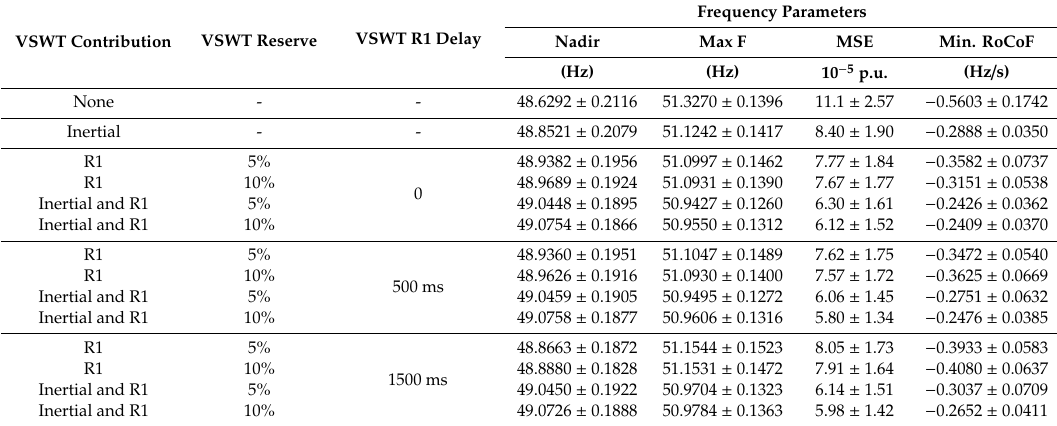
Table 3. Average values of the twenty-two schedules of frequency parameters considering proposed VSWTs contributions, reserves and delays.